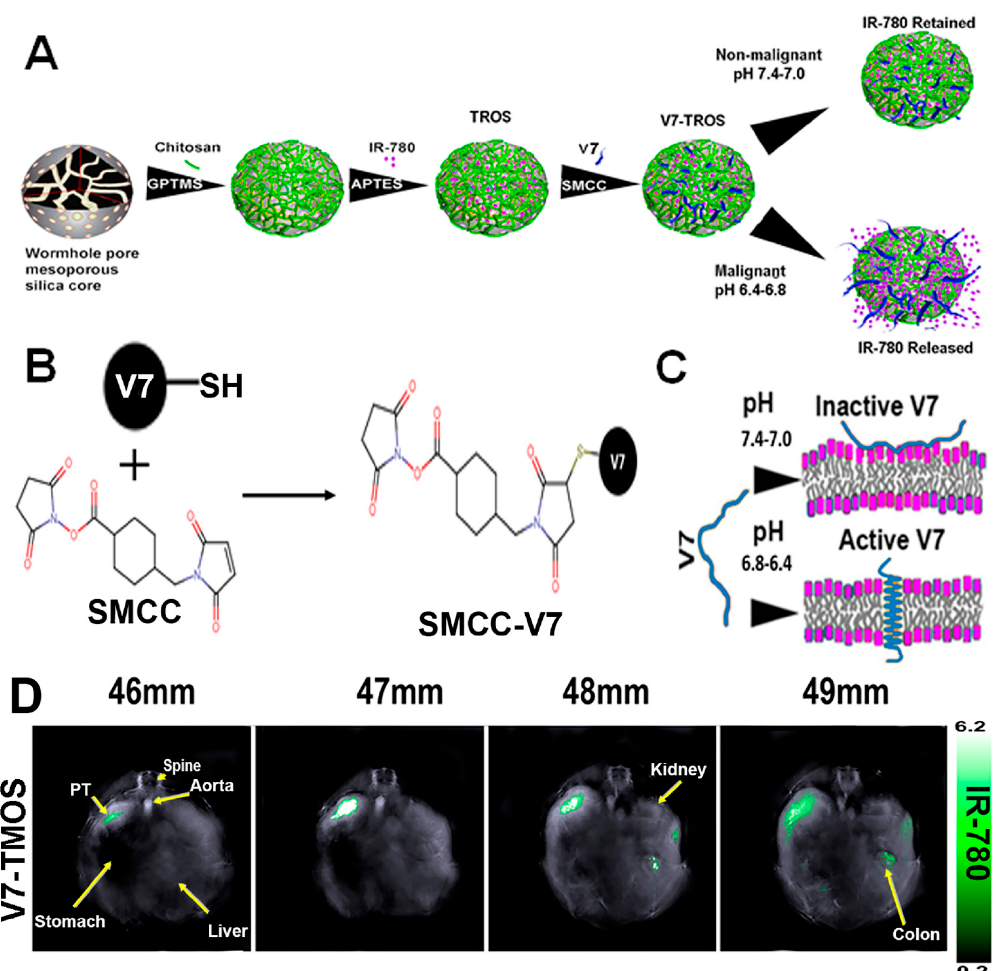
Figure 6. Construction of the low-pH-targeted MSN NP for photoacoustic imaging of pancreatic ductal adenocarcinoma. ( A ) Schematic Illustration of the Components and Formation of V7-TROS NPs, including V7-TMOS, V7-TEOS and V7-TPOS. ( B ) Conjugation Chemistry of SMCC to the Cys- teine Residue on the V7 Peptide, and ( C ) the Activation Mechanism of the V7 Peptide in Acidic Environments. ( D ) Biodistribution of V7-TMOS in axial slices showing accumulation within the tu- mor, kidney, liver, and spleen Figures were adapted based Refs. [77,154] with permissions. Copy- right 2021 American Chemical Society.